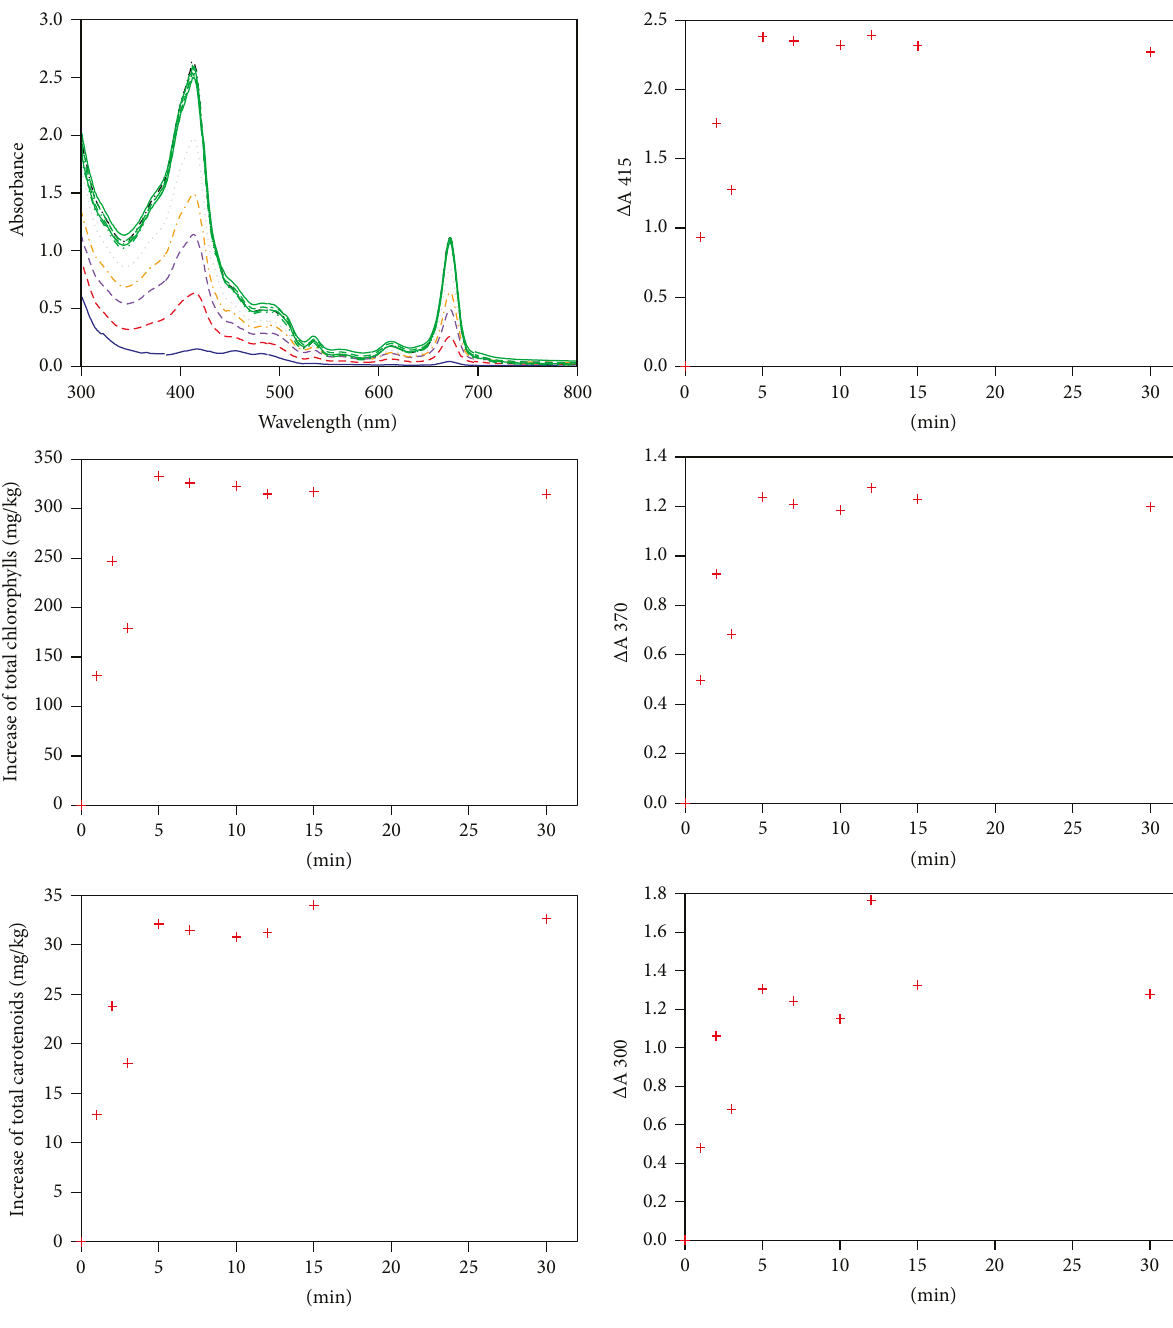
Figure 3: Laurel ultrasound maceration, results of UV-Vis measurements. For comparison, the results for 20 hours of conventional maceration are as follows: increase in chlorophylls, 63 mg; increase in carotenoids, 7.2mg; Δ A 415, 0.456; Δ A 370, 0.236; and Δ A 300,